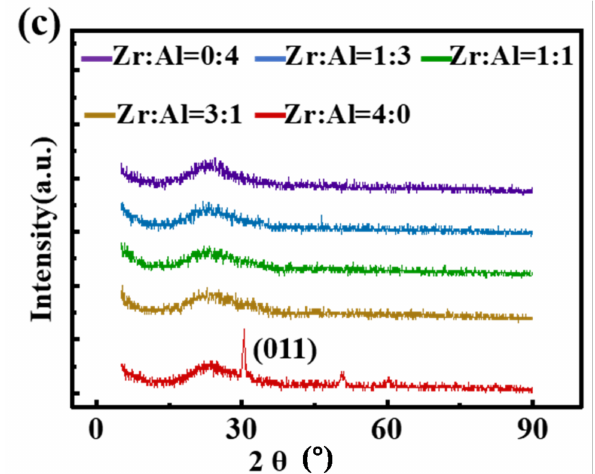
Figure 3. XRD patterns of the ZAO films of di ff erent ratios annealed at: ( a ) 300 ◦ C; ( b ) 400 ◦ C; and ( c ) 500 ◦ C, respectively.